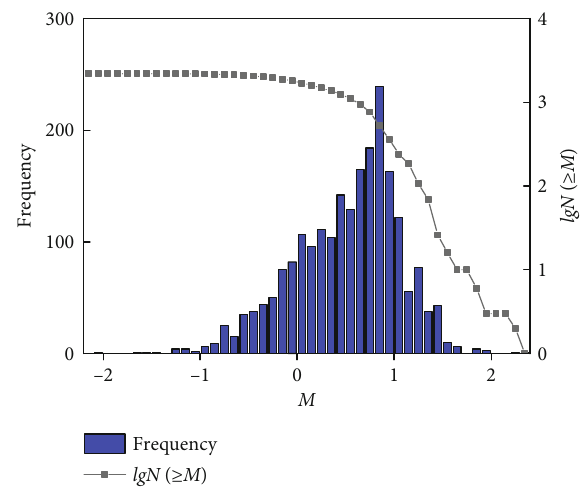
Figure 3: Relationship between frequency and